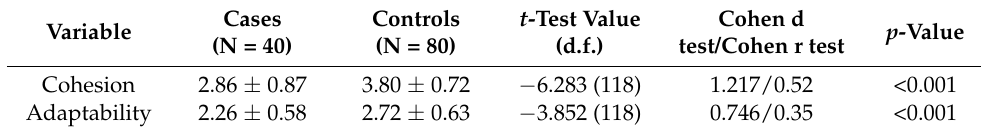
Table 2. Comparison of family dimensions “cohesion and adaptability” among the study groups. Variable